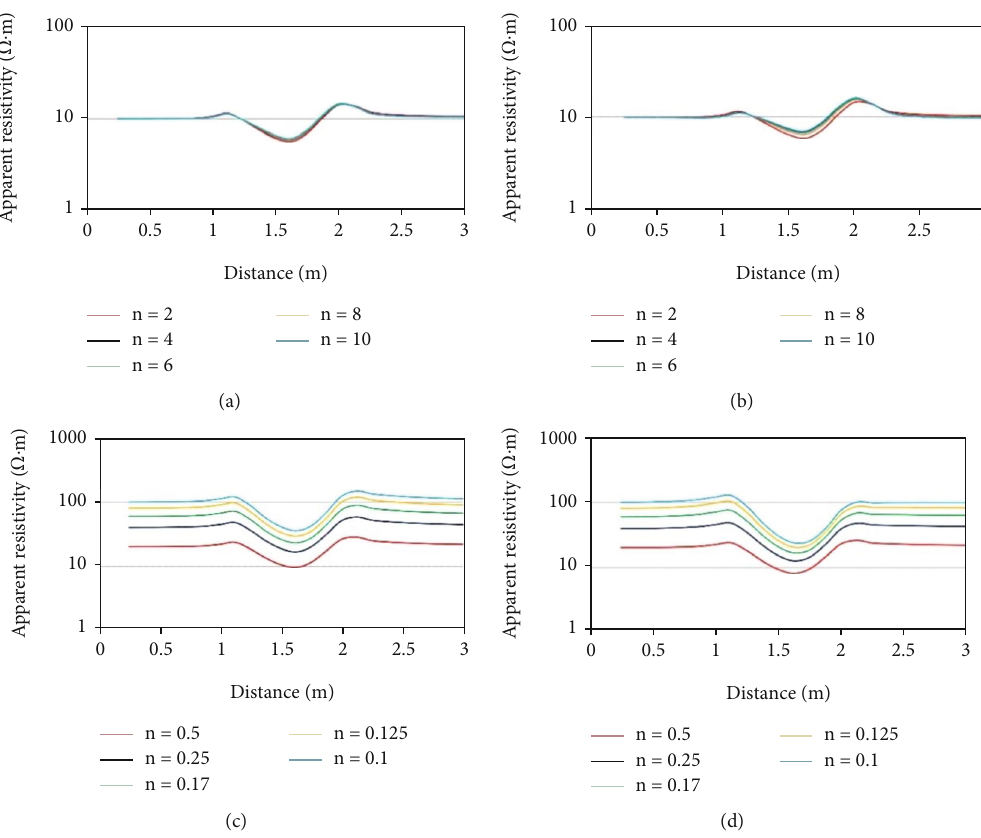
< ρ dy = 1 : 2m , dy = 0 : 6 m ; (b) ρ ter het 1 2 and > ρ dy = 1 : 2m , dy = 0 : 6m ter het 1 2 and